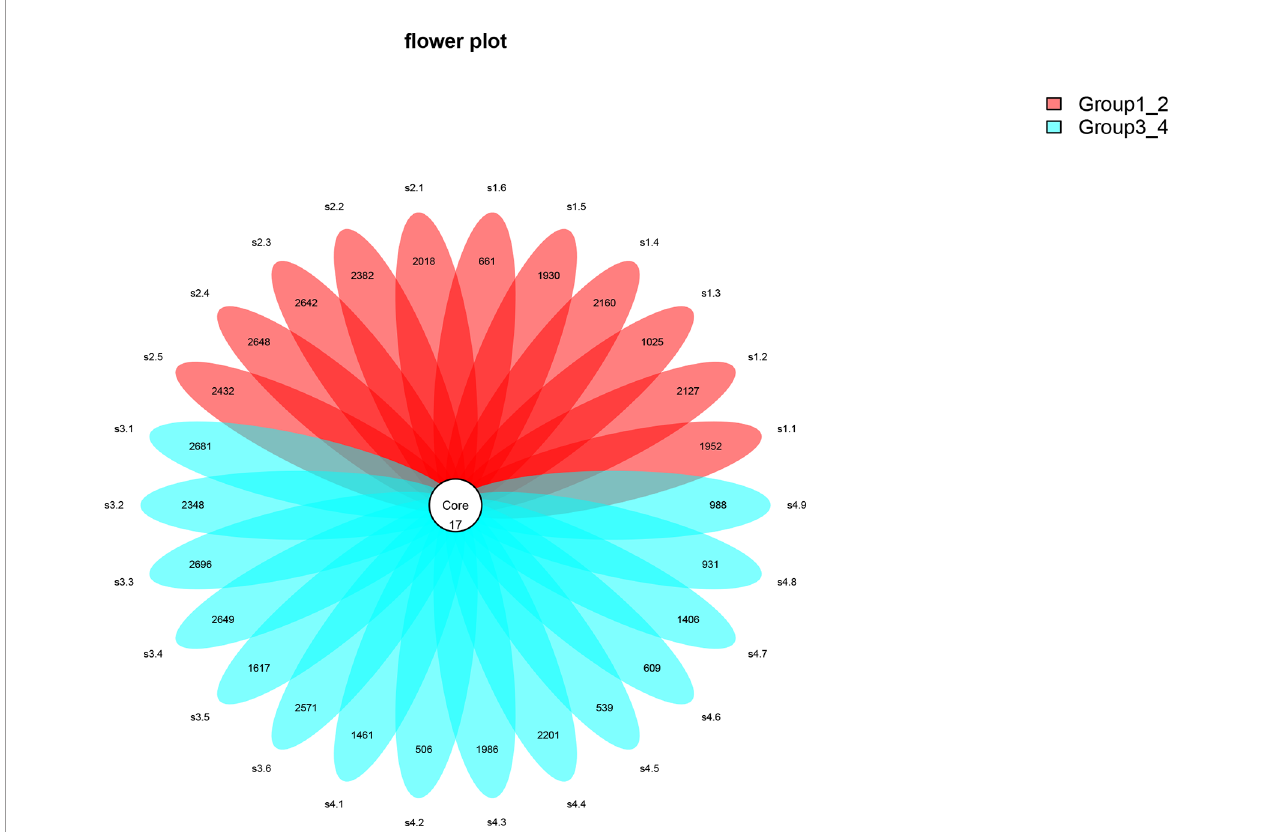
FIGURE 2 | The number of OTUs in 26